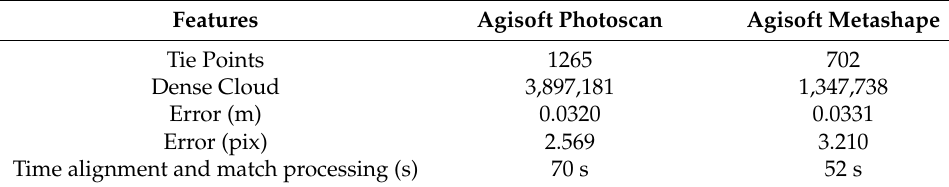
Table 4. Comparison values between the two software versions.